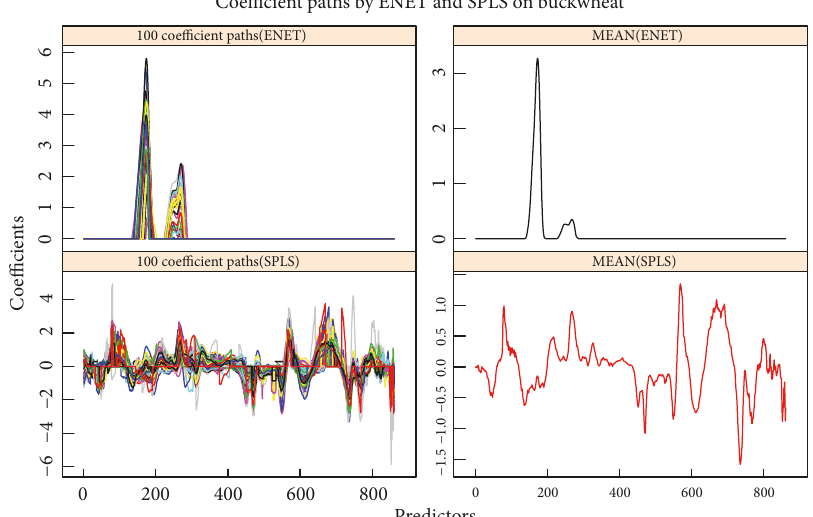
Figure 10: Coefficients paths of buckwheat by replicating 100 times. The left subgraphs are the coefficient paths by Enet and SPLS based on 100 replications, and the right subgraphs are the mean of coefficients by the two